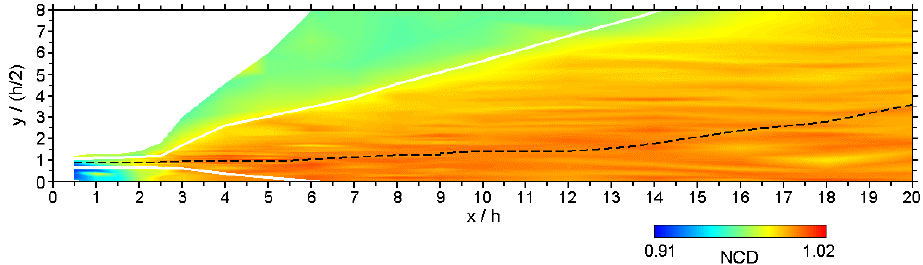
Fig. 10 Isocontour map of NCD between streamwise fluctuating velocities.